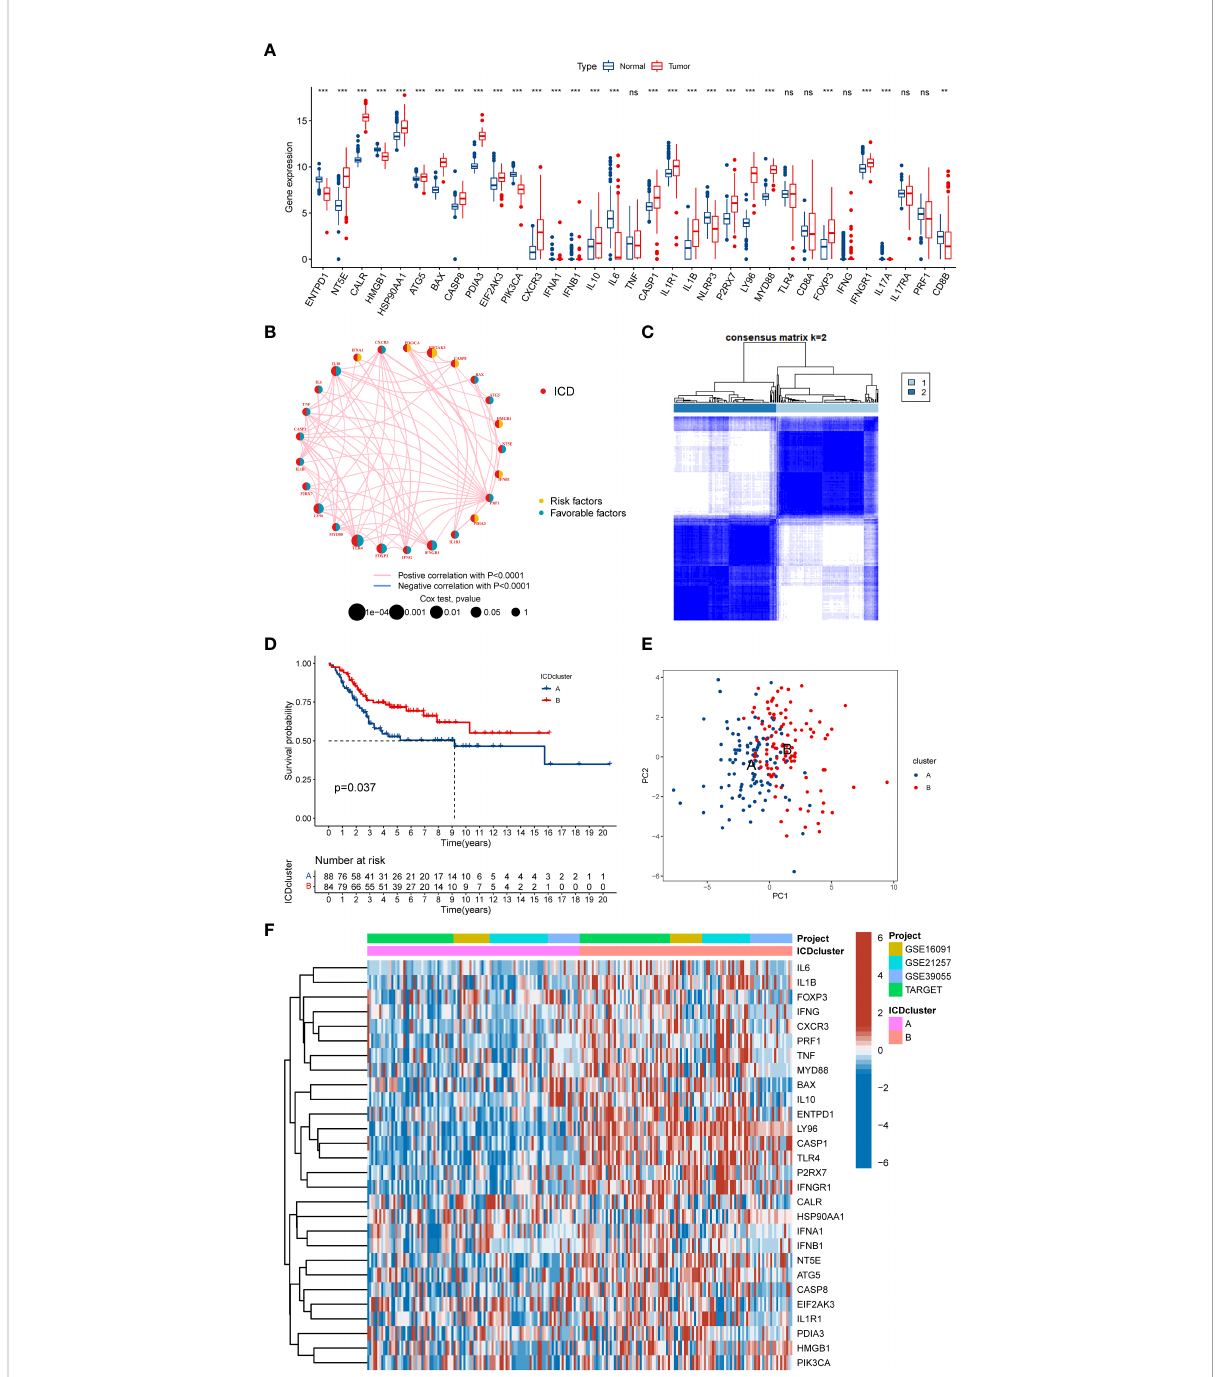
FIGURE 2 The expression landscape of ICD-related genes in OS. (A) The expression of ICD-related genes between OS and normal tissues. (B) Interaction among ICD-related genes in OS. The line connecting the ICD-related genes represents their interaction, the red line represents positive correlation, the blue line represents negative correlation, and the line thickness represents the strength of the association between ICD-related genes. The circle size indicates the P-value, the yellow ring represents risk factors, and the blue ring represents favourable factors. (C) K = 2 was identi fi ed as the optimal value for consensus clustering. (D) K-M Survival analysis of two ICD-related subtypes in OS patients. (E) PCA analysis indicates a remarkable difference in distinct ICD-related subtypes. (F) Differences in ICD-related gene expression levels between the two distinct subtypes. ICD, Immunogenic cell death; OS, Osteosarcoma; K-M, Kaplan-Meier; PCA, Principal component analysis. ns, no signi fi cance, **p < 0.01, ***p <